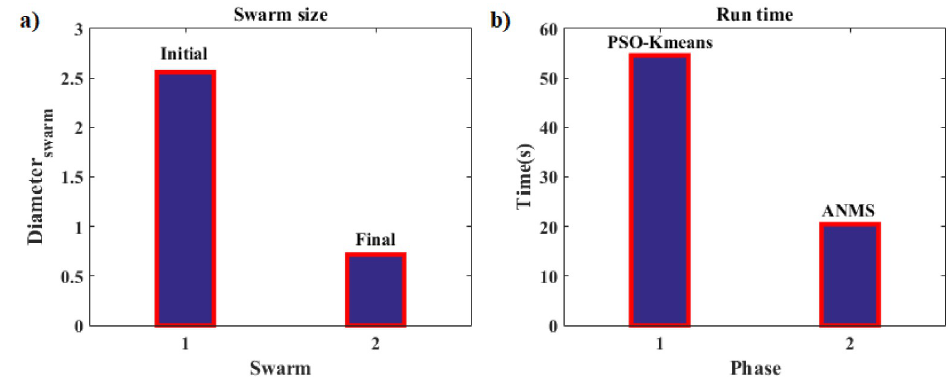
Fig 18. Case 1 (100 × 20). (a) Diameters of the initial and final swarms and (b) Run time of Phases 1 and 2.